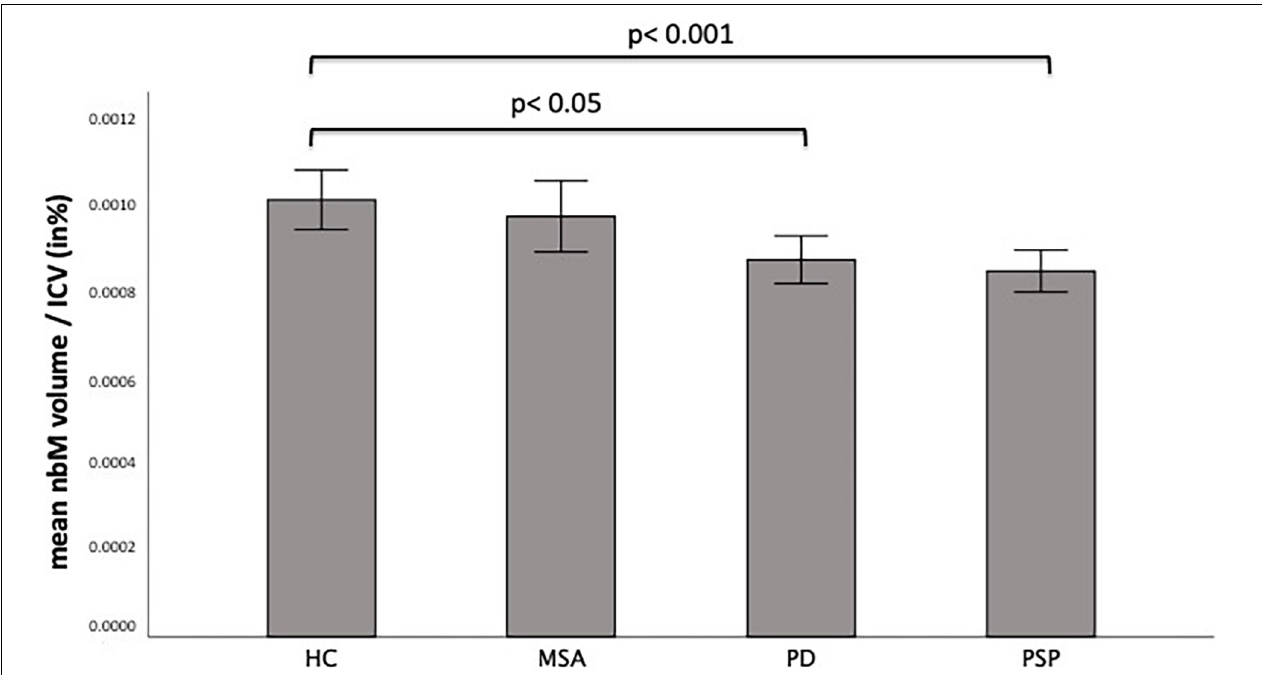
FIGURE 2 | Mean nucleus of basalis Meynert (nbM) volumes corrected for intracranial volume (ICV) per diagnosis. The bar chart displays the nbM volume corrected for the individual ICV in percent in healthy controls (HC) and patients with Parkinson’s disease (PD), Multiple system atrophy (MSA), and Progressive supranuclear palsy (PSP). Significant differences are marked with the corresponding p